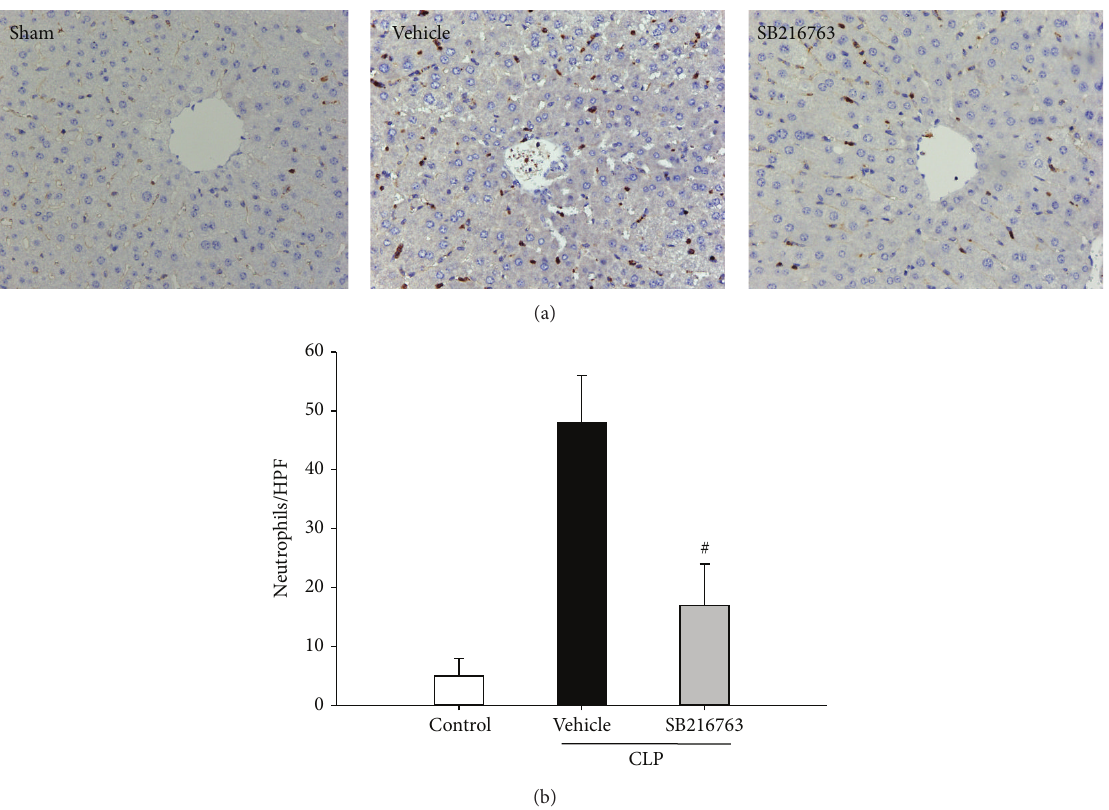
Figure 3: GSK-3 𝛽 inhibition reduces the neutrophil infiltration in liver following CLP. (a) MPO staining was performed on liver sections from mice at 20 h after CLP. (b) The numbers of MPO-positive neutrophils that infiltrated the liver were determined (original magnification × 400). Representative images from 6 mice/group were selected. Data are shown as mean ± SD. 𝑛 = 6 per group. # 𝑃 < 0.01 compared with vehicle-treated group.